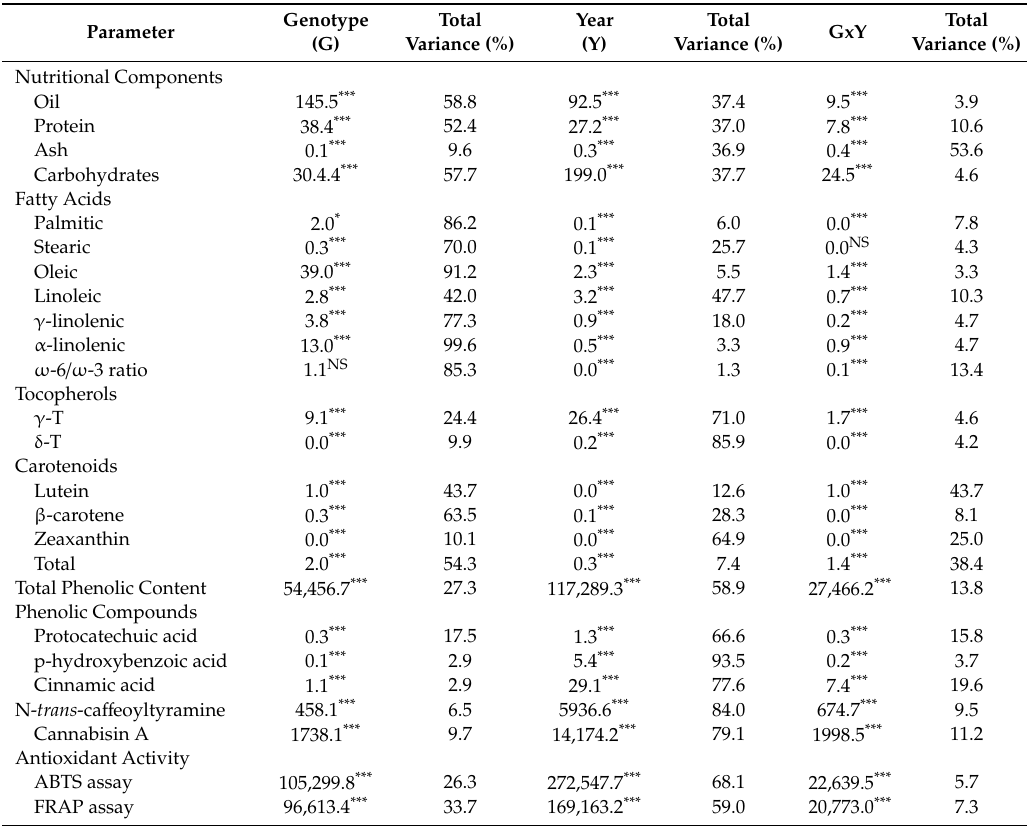
Table 3. Statistical significance (ANOVA) of genotype, growing year, and their interaction on nutritional components, fatty acids composition, phytochemical profile, and antioxidant activity of hemp seeds from the seven industrial hemp cultivars cultivated in this study and for the three growing seasons (2016, 2017, and